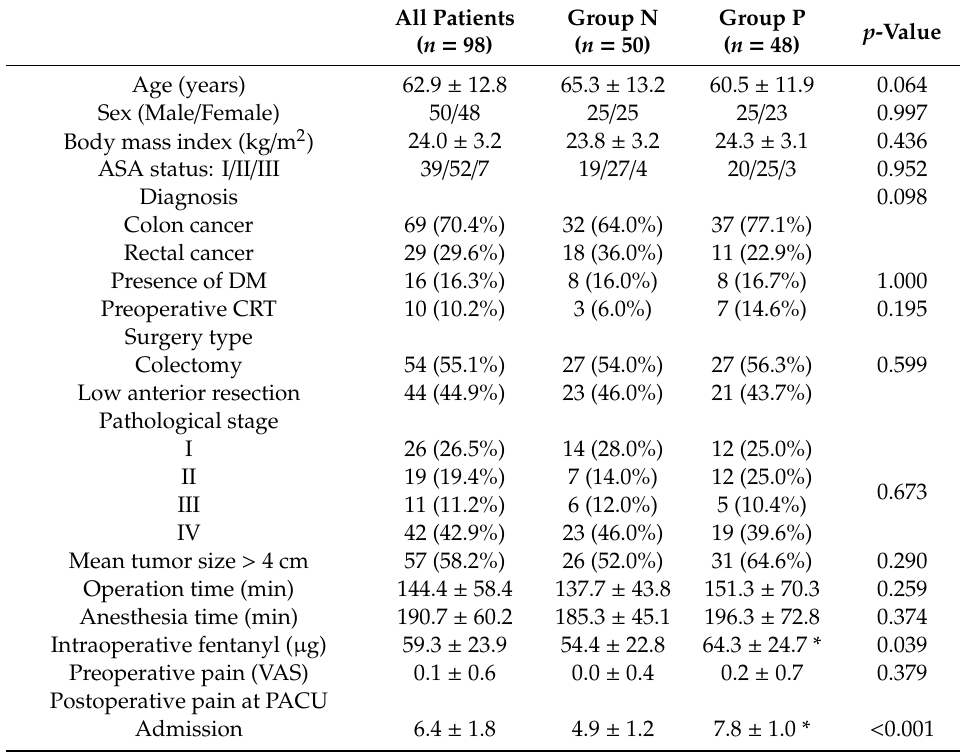
Table 1. Demographic and clinical characteristics of the included